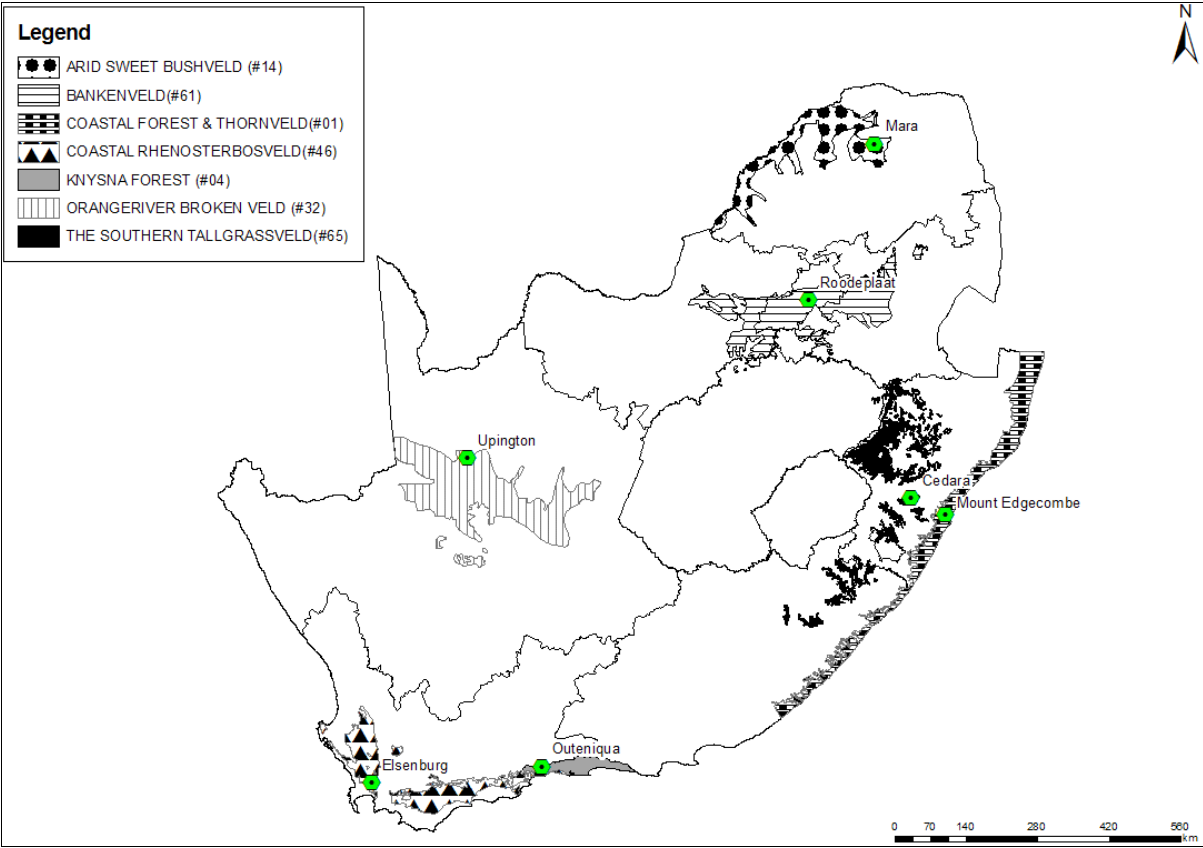
Figure 2: Locations of the seven hydroclimatic zones selected after Schulze 28 . The vegetation types represented by these zones are labelled according to Acocks 32 . See also Table